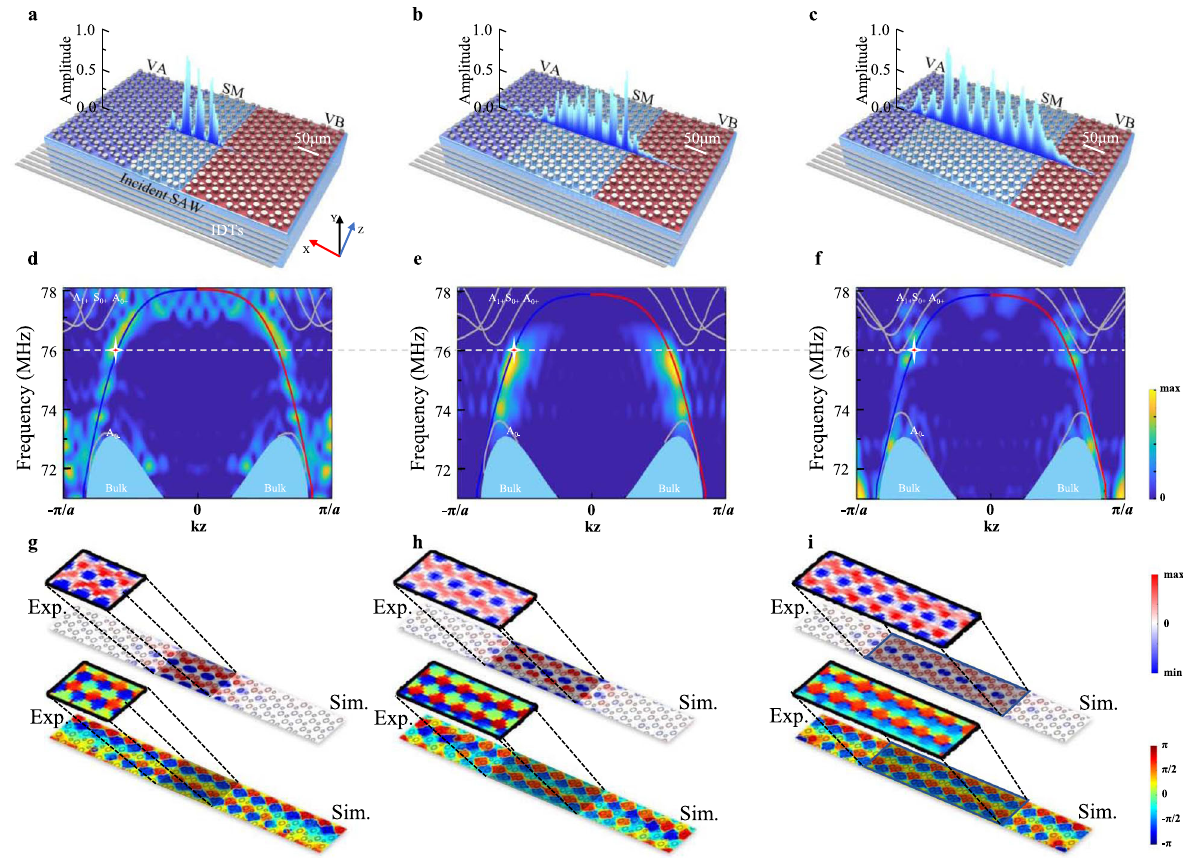
Fig. 2 Extended topological valley-locked states for SAWs. a – c (bottom) Schematics of three heterostructured valley interfaces (see SEM images in Fig. S2), with increasing molecular layers (from 3, 5, to 7, respectively) of SAW “ semimetal ” (SM) doped inside a VA and a VB. (upper) Experimentally measured SAW out-of-plane amplitude distributions crossing the doping areas. d – f Calculated and experimentally measured band structures of the heterostructured interfaces. The color bar represents the density of energy. g – i Simulated and experimentally imaged SAW out-of-plane displacement and phase distributions of the heterostructured interfaces (at 76MHz shown in the fi gures), demonstrating a pseudo-diffusion-like phase uniformity of these edge